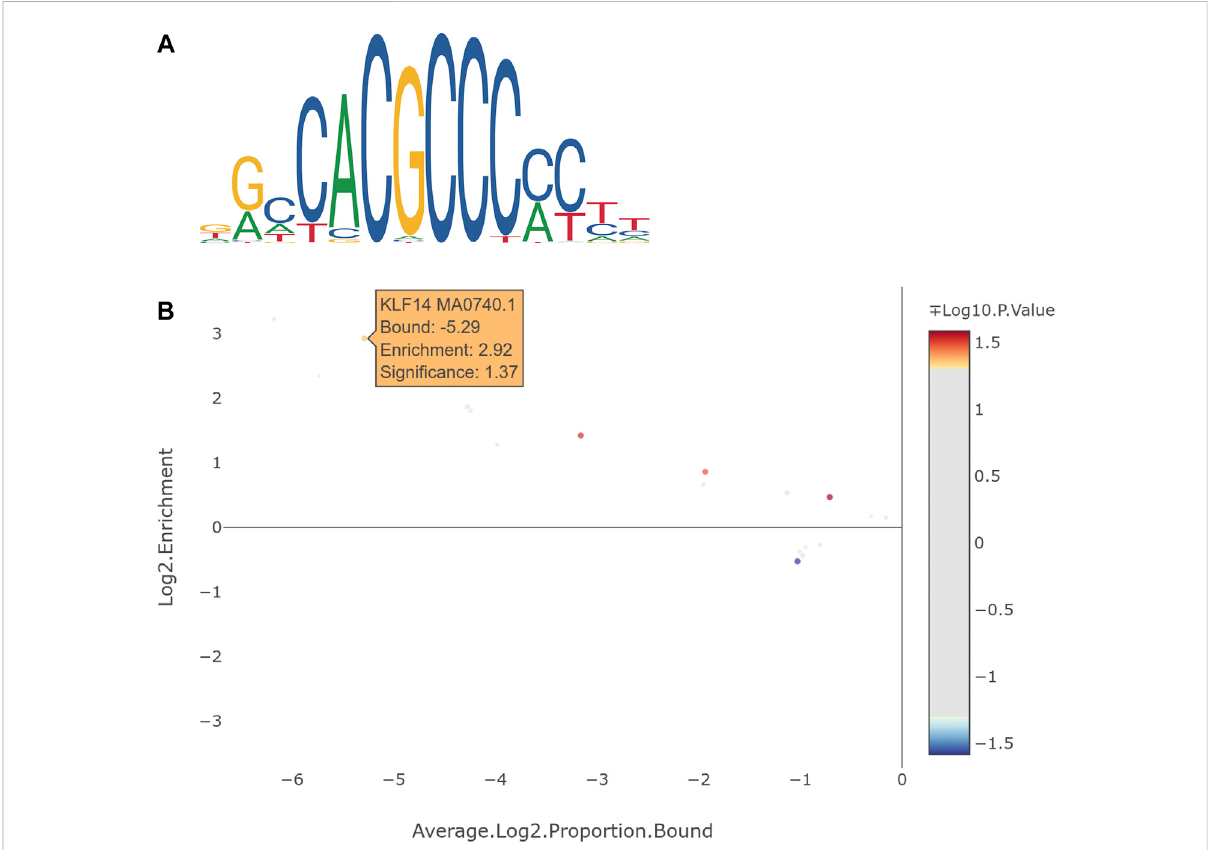
FIGURE 3 (A) Graphical representation of the position frequency matrix of the KLF14 transcription factor. (B) Result of transcription factor binding site enrichment analysis for KLF14 with genes from expression genome wide associations studies with genome wide signi fi cant association. All available KLF transcription factors were included as controls for the speci fi city of KLF14 binding site enrichment.